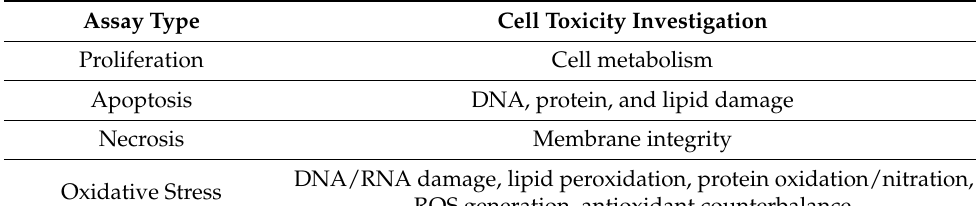
Table 1. In vitro assay types used for the analysis of